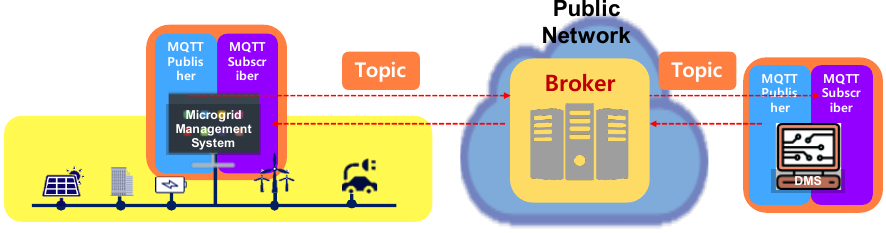
Figure 5. MQTT-based communication architecture.